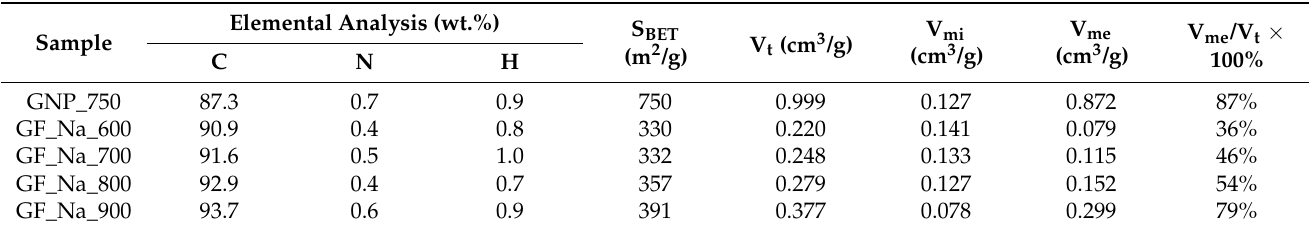
Table 1. Elemental composition and porosity parameters obtained from N 2 sorption analysis of 3D graphene.